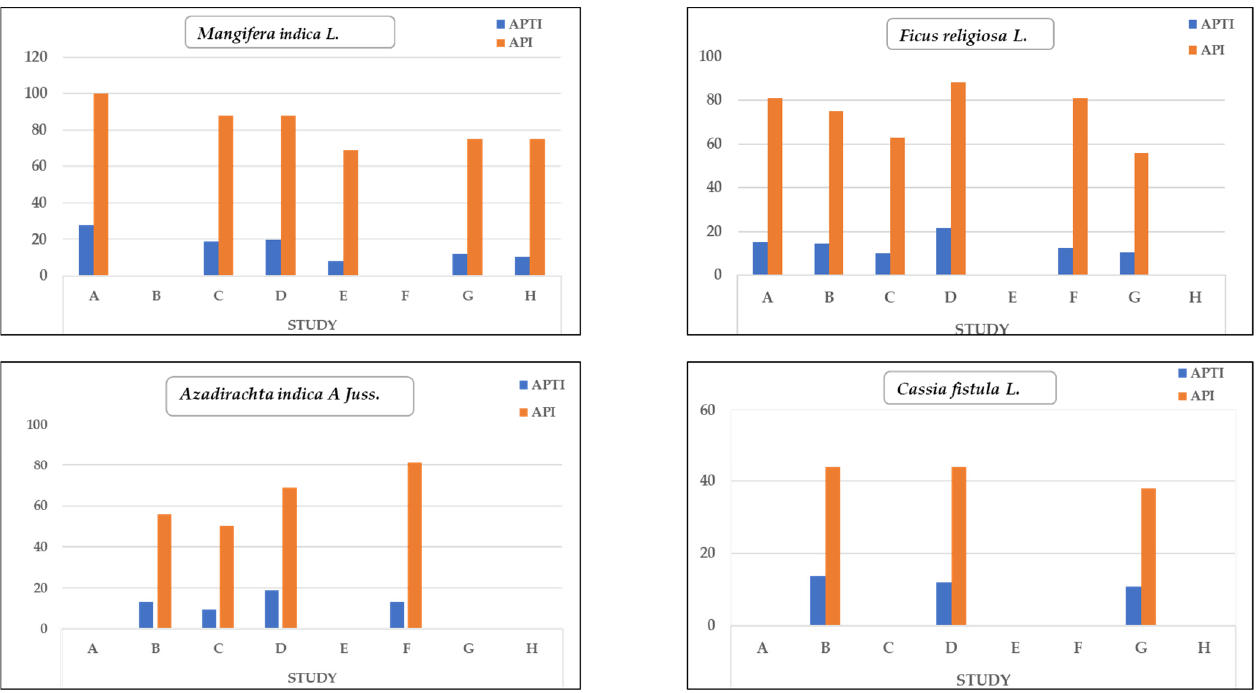
Figure 4. Variations of APTI and API in the four different plants from eight different studies. Table 5. Evaluation of plant species based on APTI and some biological and socio-economic param- eters.